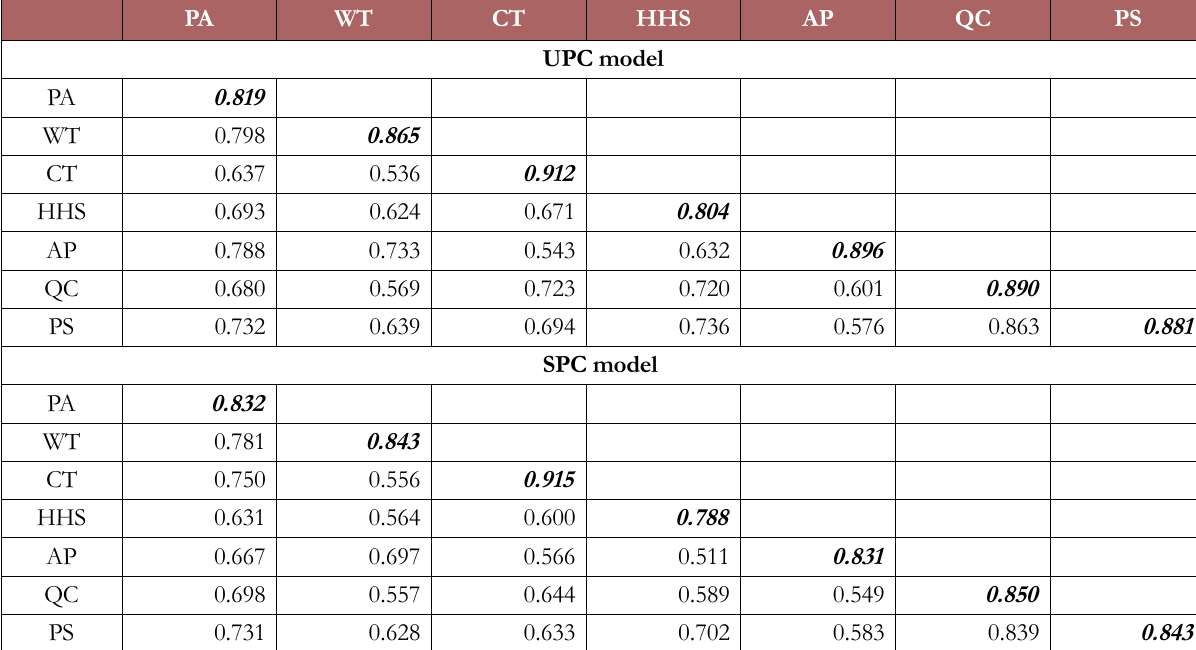
Table 6. Discriminant validity